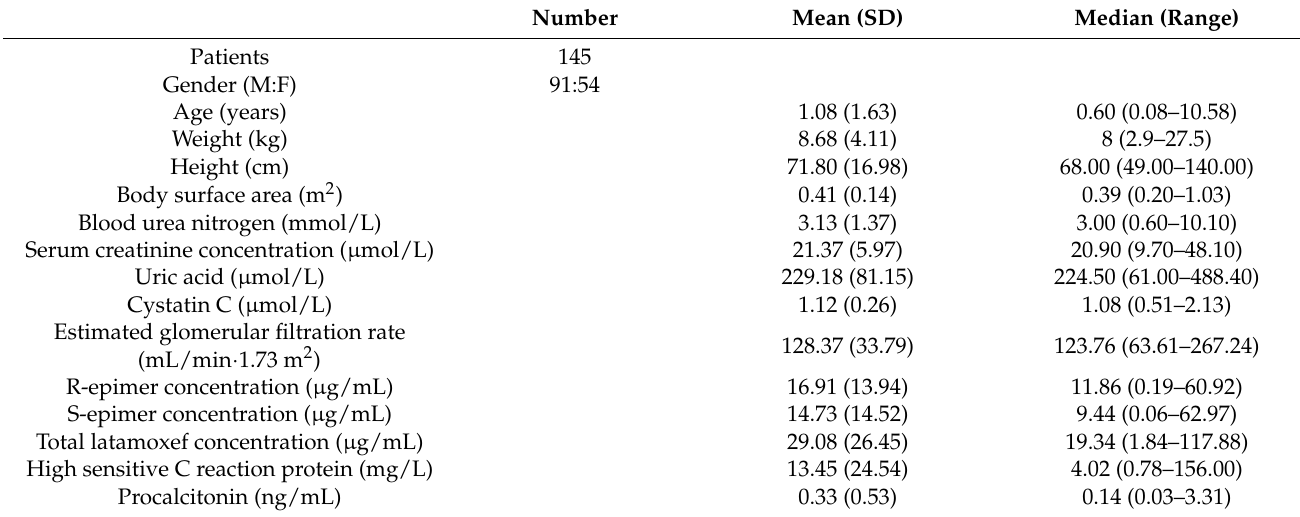
Table 1. Demographic and physiological characteristics of 145 pediatric